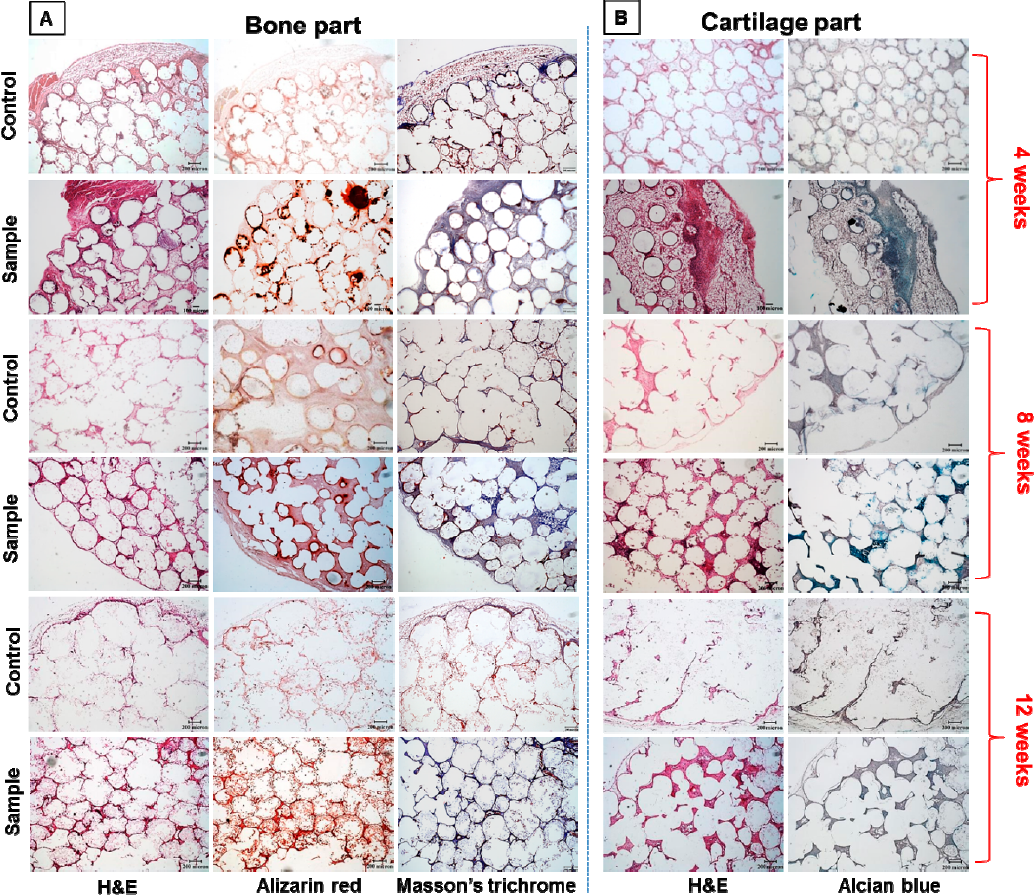
Figure 13. In vivo histological staining of bone ( A ) and cartilage ( B ) parts of co-cultured BMSCs and chondrocytes in OC scaffolds. H&E, Alizarin red, and Masson’s trichrome stains of the bone part and H&E and Alcian blue stains of the cartilage part are shown for the cell-seeded sample and the acellular control 4, 8, and 12 weeks post-implantation in nude mice. Bar = 200 µm.